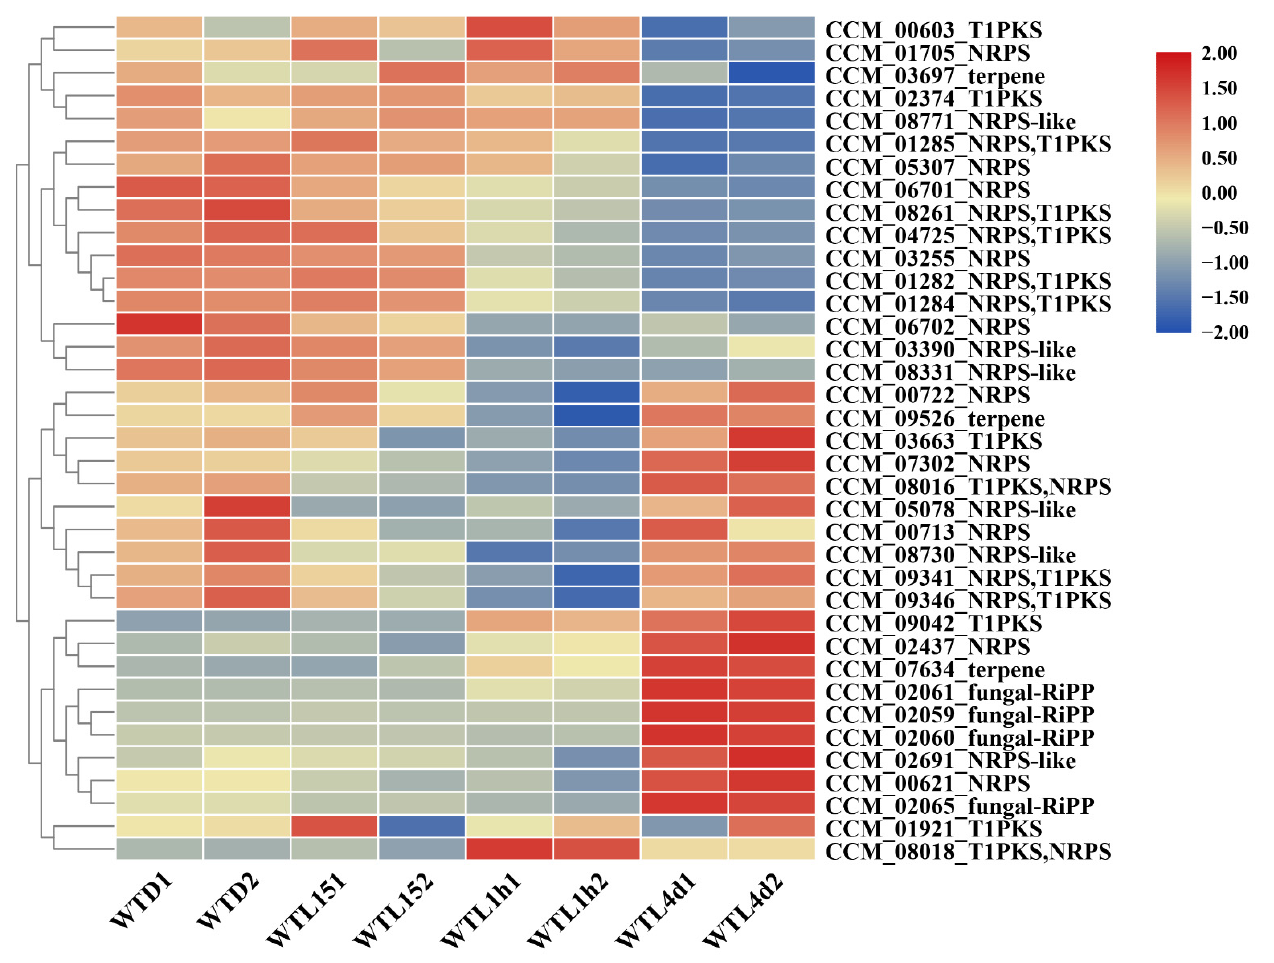
Figure 5. Heatmap of gene transcription of core genes involved in secondary metabolite cluster predicted by AntiSMASH under different light conditions. Each column represents expression values normalized by log2 (FPKM+1) at the indicated samples.